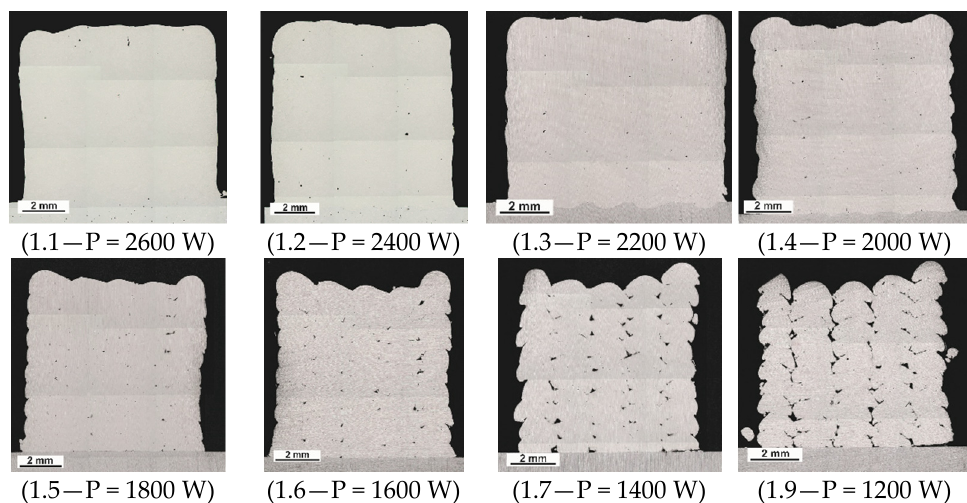
Figure 4. The thin cross-sections of the samples (first series), laser power in the range of P = 2600 W (1.1) to P = 1200 W (1.8).